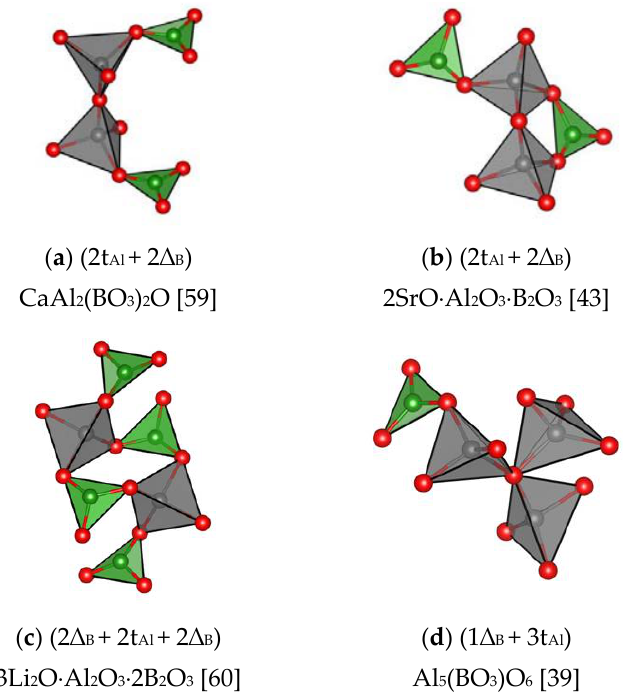
Figure 7. CRP in di ‐ and trivalent metal borates different from the FSU and CSU in these compounds (the green and red balls represent B, and O atoms, respectively). ( a ) boracite [55]; ( b ) boracite high [56]; ( c ) CaB 2 O 4 (II) [16]; ( d ) CaB 2 O 4 (III) [21]; ( e ) Ca 2 B 6 O 11 [57]; ( f ) CaB 4 O 7 [58]; ( g ) SrO 2B 2 O 3 [23]; ( h ) BaO 2B 2 O 3 [47]; ( i ) BaO 4B 2 O 3 [48]; ( j ) R (BO 2 ) 3 [27]; ( k ) johachidalite, CaAl(B 3 O 7 ) [34]; ( l ) R Al ‐ metaborates (R = Ce − Nd) [35].